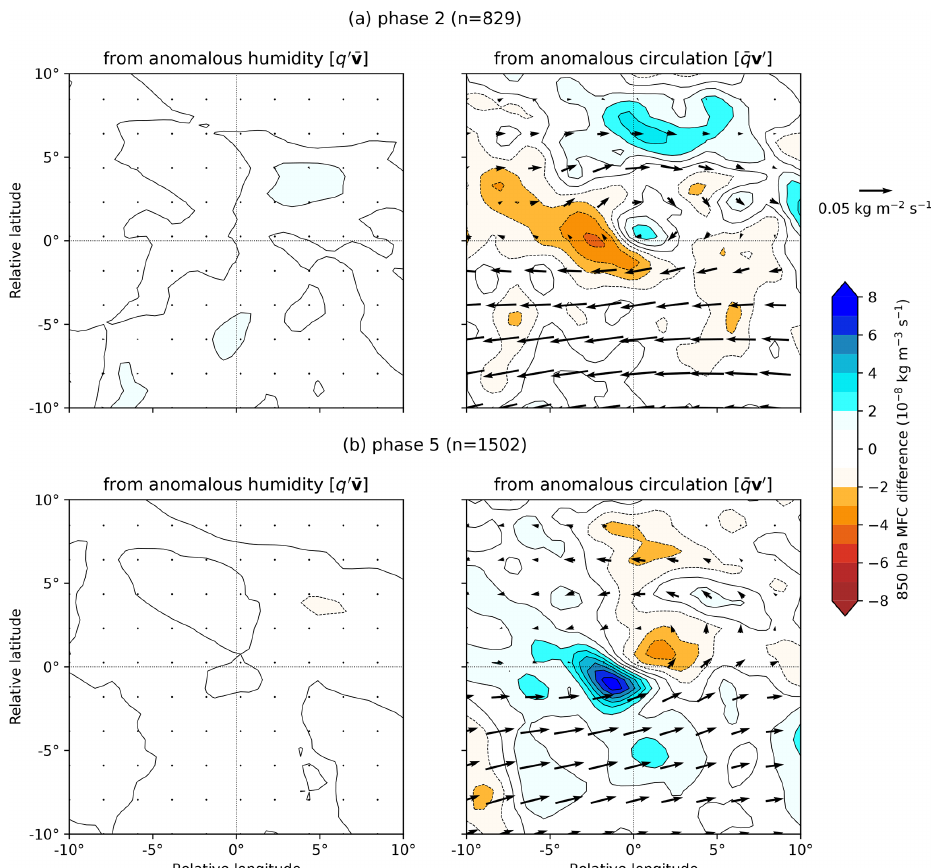
Figure 9. Contribution to LPS-centred anomalous 850hPa moisture flux and moisture flux convergence in (a) BSISO phase 2 and (b) BSISO phase 5 from (left) anomalous humidity and (right) anomalous circulation. In each case the contribution is computed by linearising about the mean LPS composite. Computed for monsoon LPSs north of 15 ◦ N.